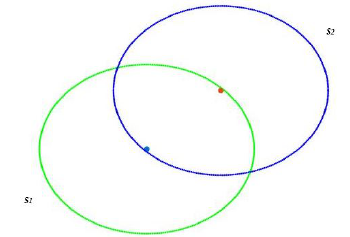
Figure 3. Two connected